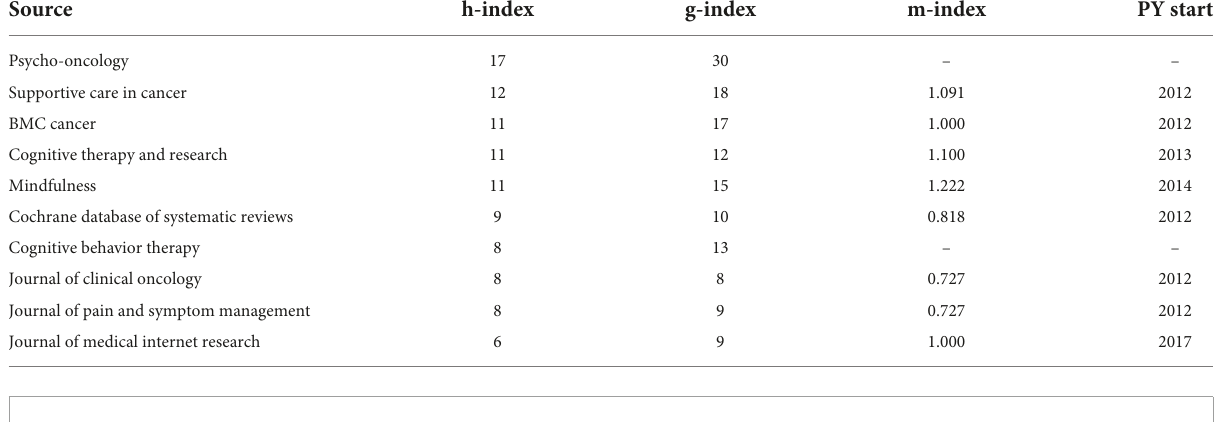
TABLE 3 Top 10 highest impact journals by source in the field.